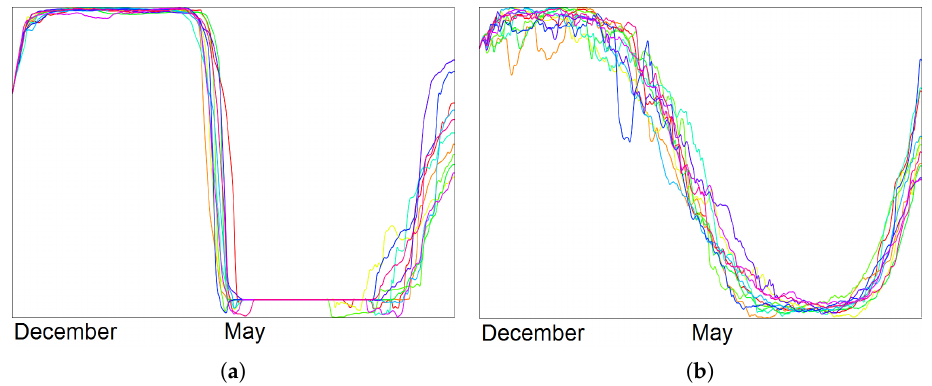
Figure 19. Plotting principal component of projection (vertical axis) over time (horizontal axis) for all 11 simulations when selecting arctic ( a ) and antarctic ( b ) region separately. For isocontour similarity, we considered isovalue 0.25 of sea snow thickness. We observe no activity during summer months in ( a ), but activity throughout the year in ( b ). Please note that the metric for the distance computation returns absolute values such that both plots are oriented the same